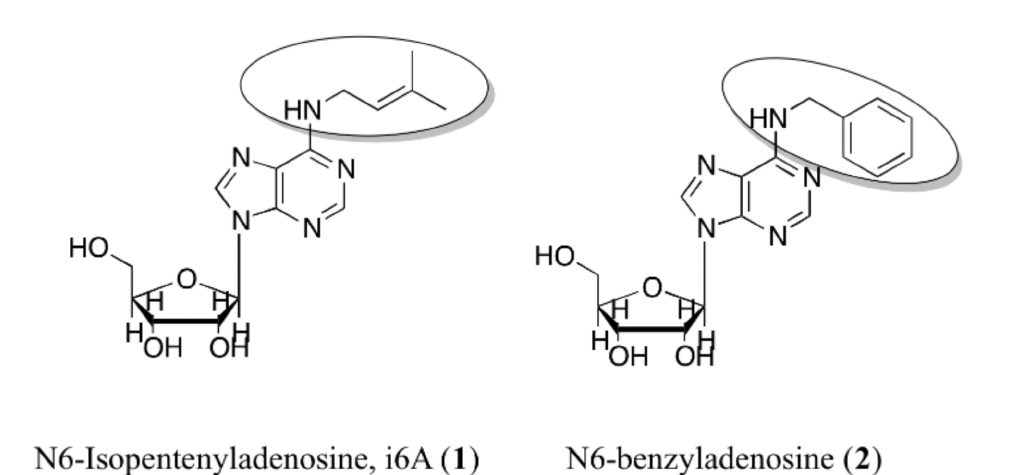
Figure 1. Chemical structures of i6A ( 1 ) and N6-benzyladenosine ( 2